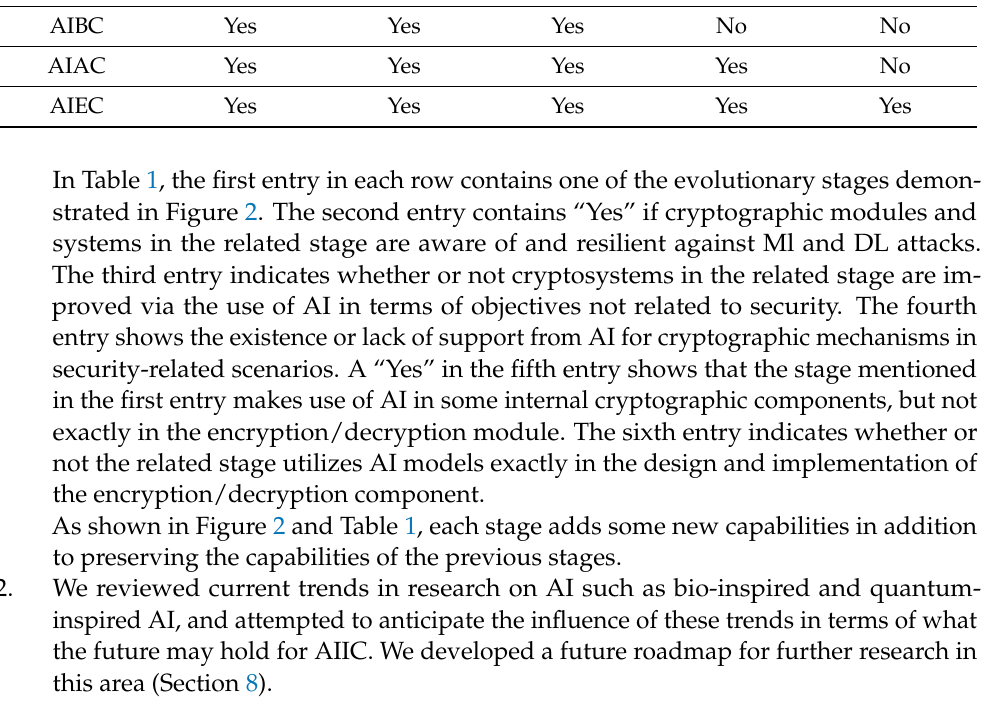
Improve Non-Sec.